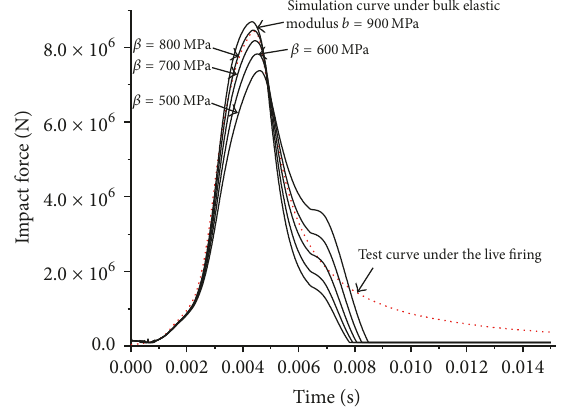
Figure8:Shockforcecurveofthehigh-powerhydraulicshockwave simulator under various bulk elastic modulus 𝛽 of oil.